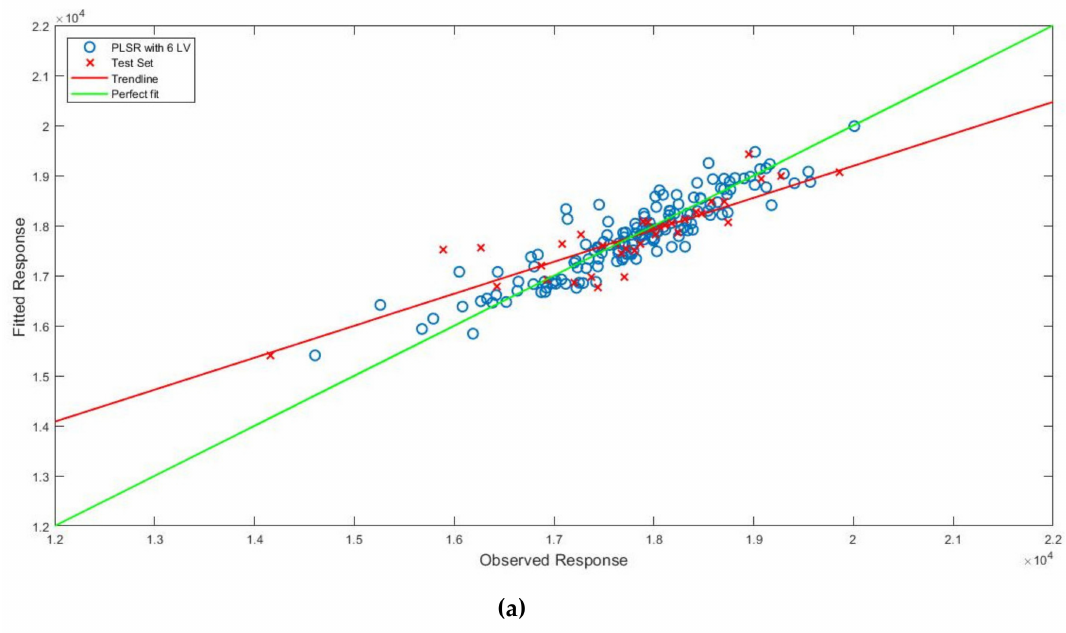
Figure 5. ( a ) Partial least squares regression plot for the prediction of GCV ad on WD st . Spectra were pre-processed using first derivative (Savitzky-Golay filter, 9-points window, second-order polynomial) using three latent variables; ( b ) Corresponding regression vector plot using vertical lines and numbers to discriminate the most important